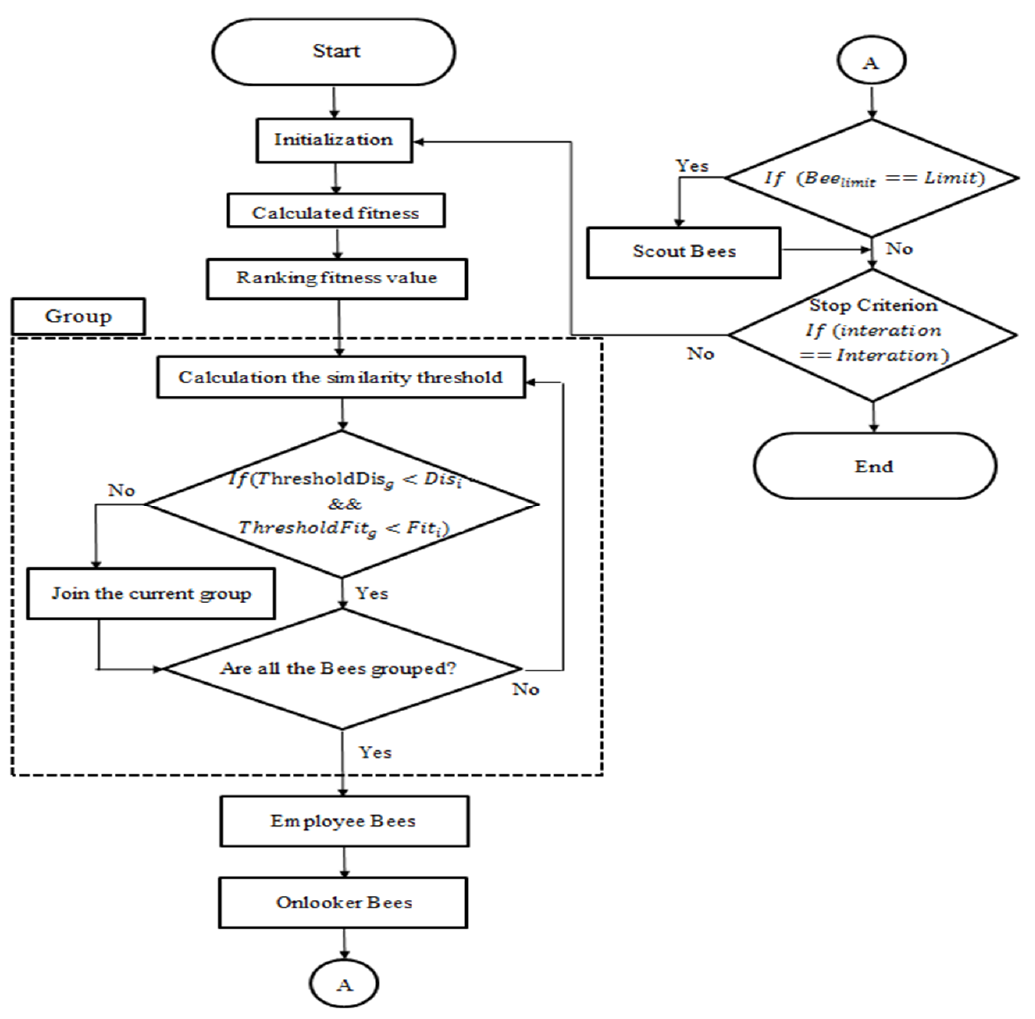
Figure 6. Flowchart of the proposed dynamic group artificial bee colony (ABC).